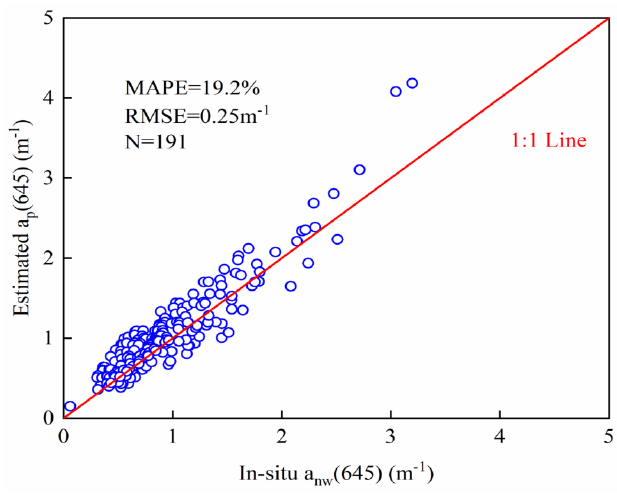
Figure 3. Comparison of in-situ a nw (645) and estimated a p (645).